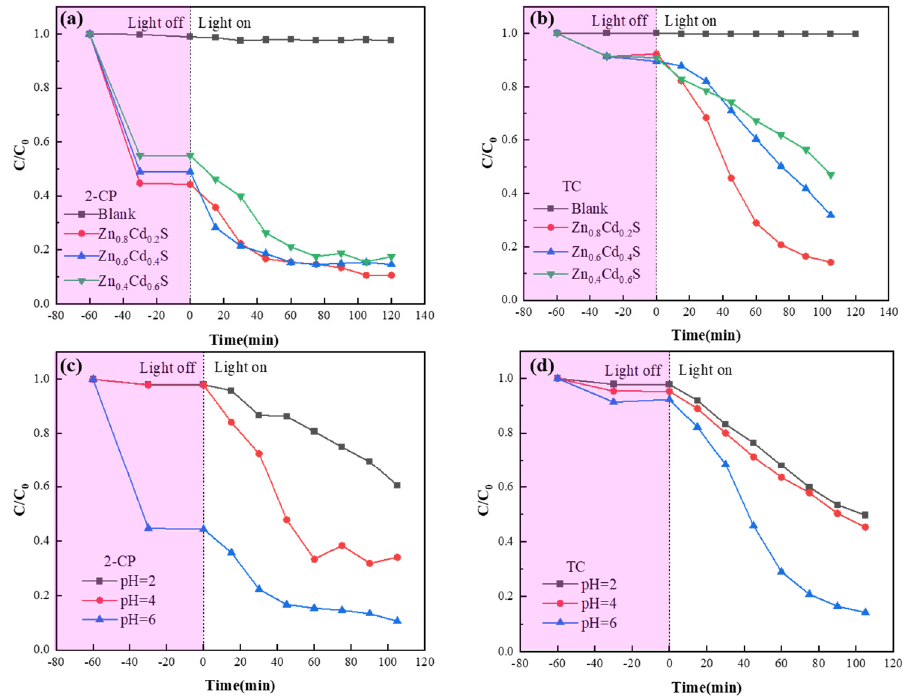
Figure 5. Photocatalytic removal curves under visible light irradiation. ( a ) Degradation in 2-CP; ( b ) Degradation in TC; ( c ) Degradation in 2-CP, HCl adjust Ph; ( d ) Degradation in 2-CP,HCl adjust pH. Table 1. Comparison of the performance of different photocatalysts for TC